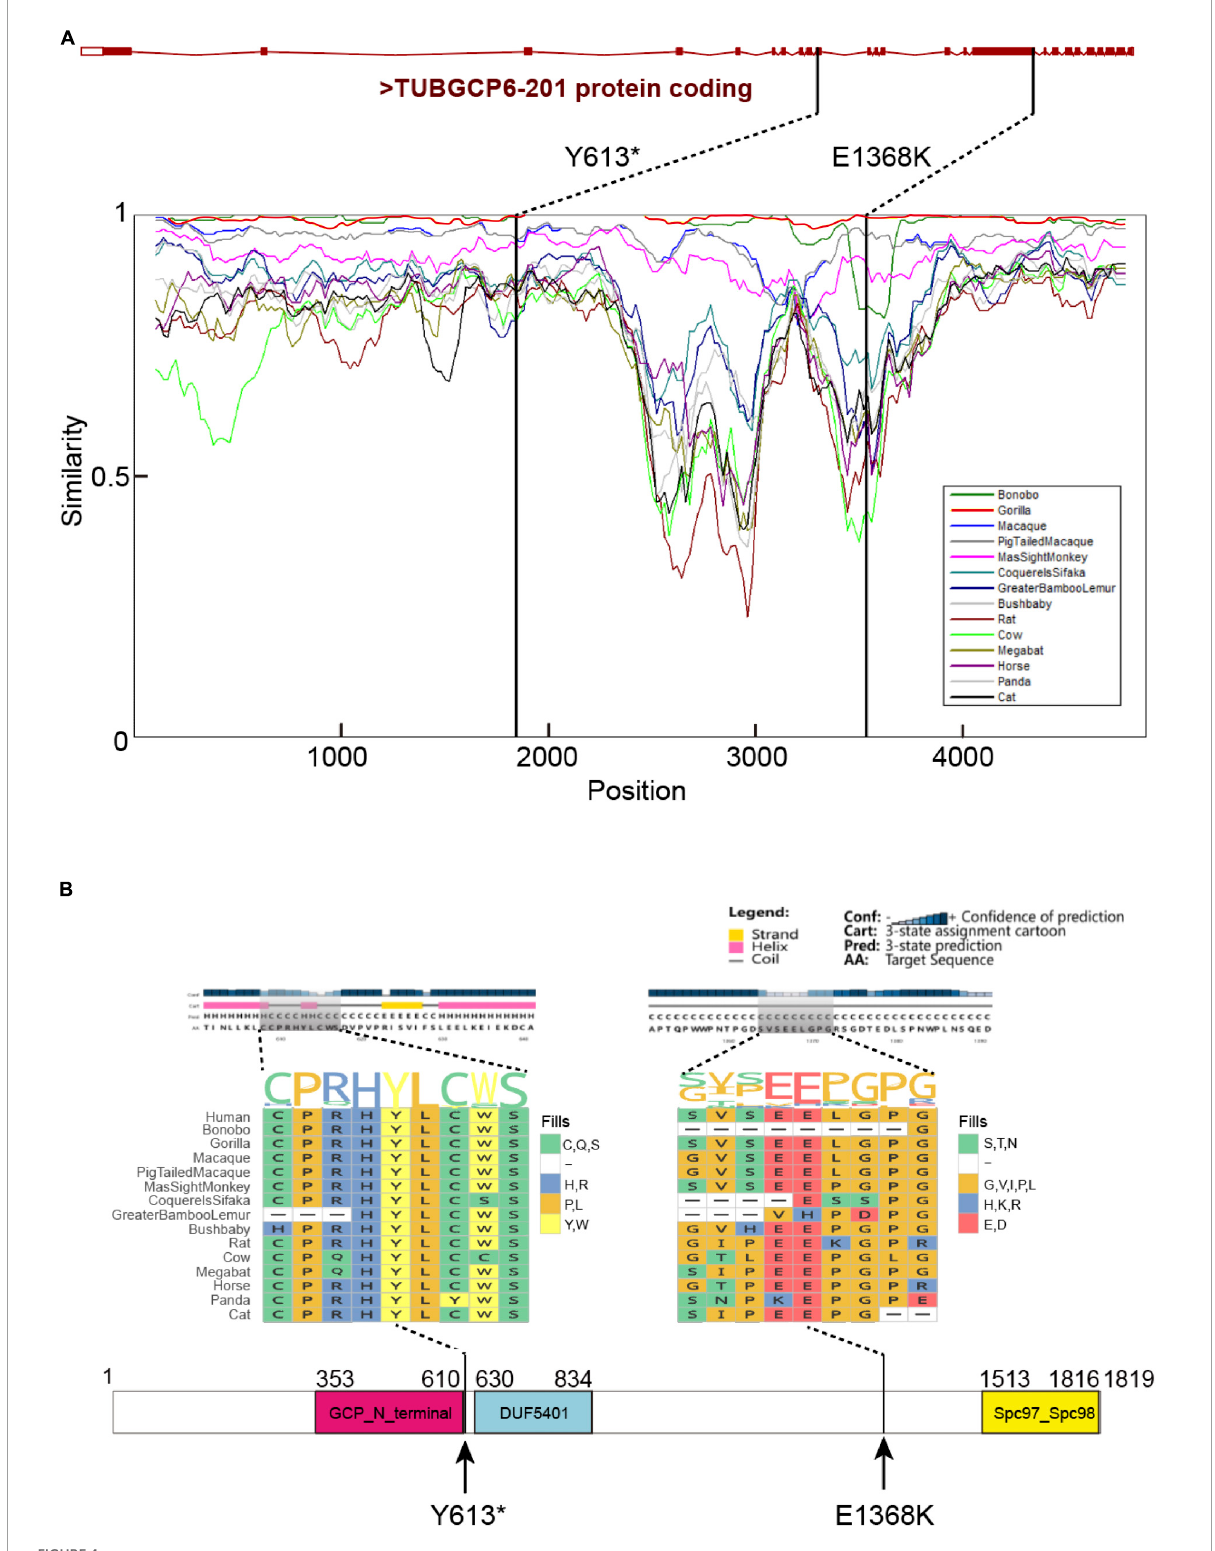
FIGURE4 (A) The gene structure of TUBGCP6, locations of the identified two variants, and the regional similarities across mammalian species. The similarity percentages were inferred with SimPlot V3.5.1 (Lole et al., 1999). (B) The protein secondary structure and multiple species protein alignment, with a focus on the two variants (Y613* and E1368K). The protein domain were inferred with PSIPRED (Jones,